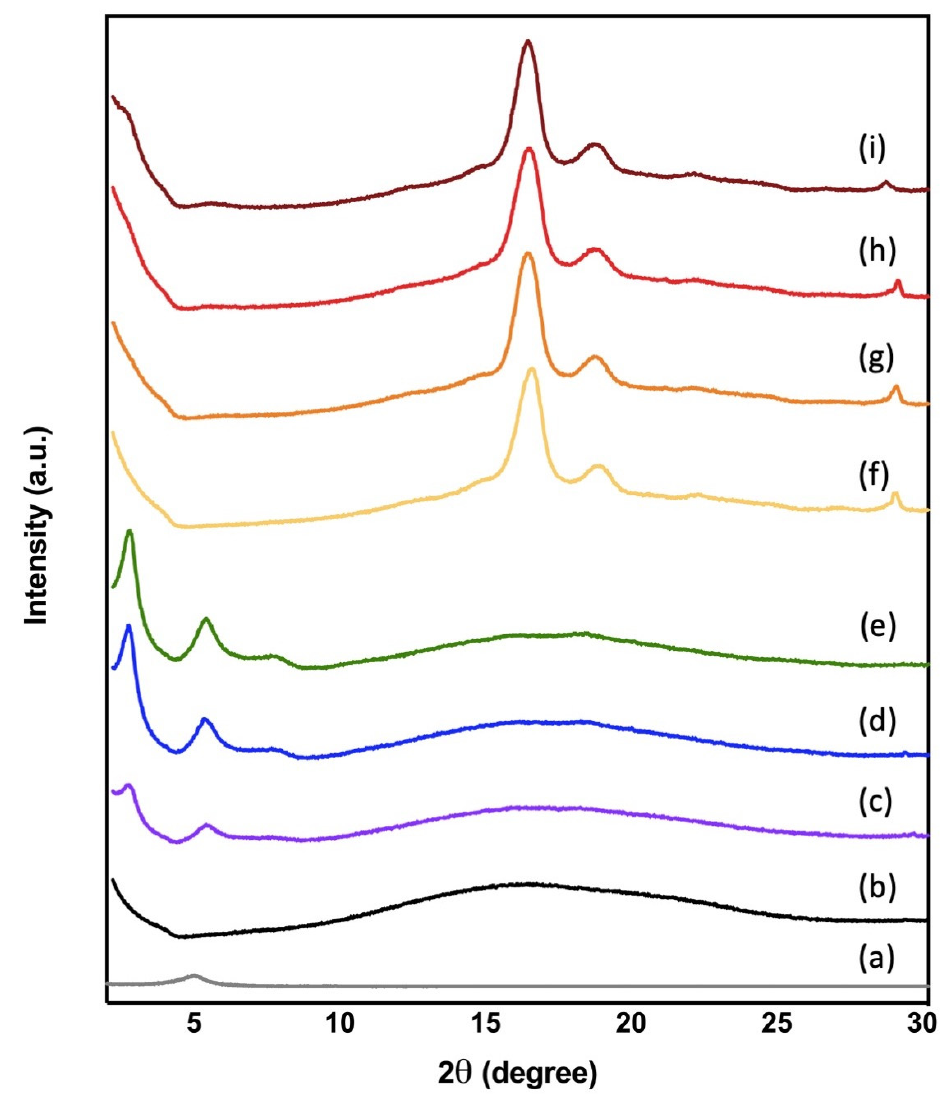
Figure 8. X-ray diffraction patterns of (a) Cloisite 30B, PLA film samples: (b) PLA neat, (c) PLA 1%C30B, (d) PLA 2%C30B, (e) PLA 3%C30B and PLA foam samples (f) PLAf neat, (g) PLAf